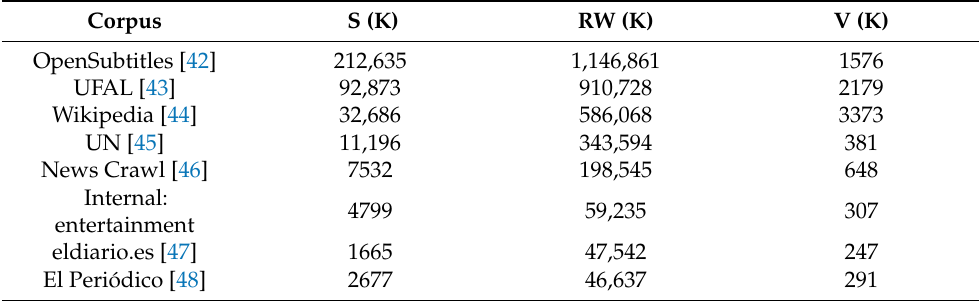
Table 2. Statistics of Spanish text resources for LM training. S = Sentences, RW = Running words, V = Vocabulary. Units are in thousands